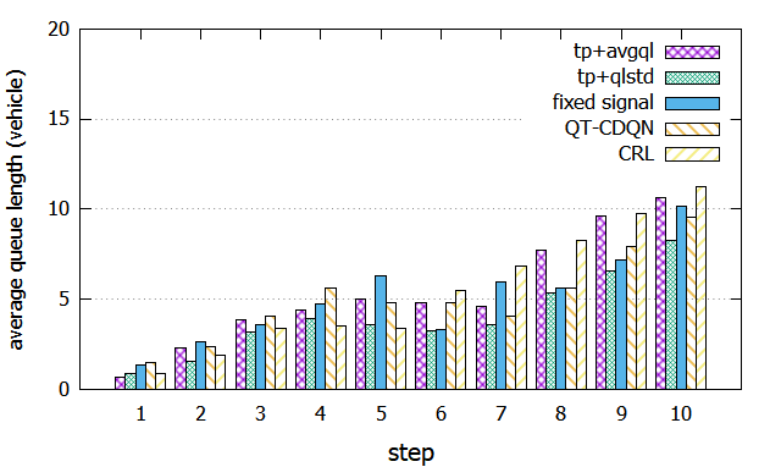
Figure 10. Performance comparison: average queue